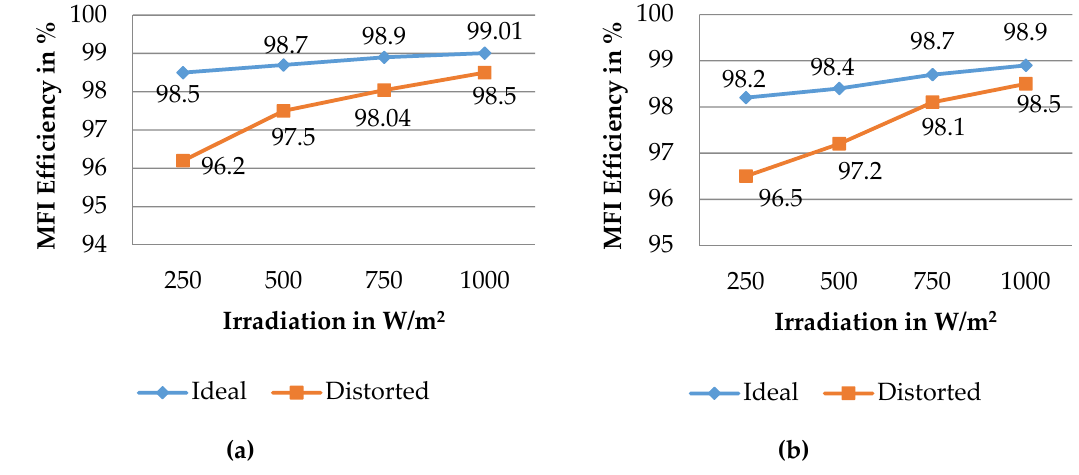
Figure 18. MFI efficiency using MB-HCC: ( a ) Full Load; ( b ) Reduced Load.